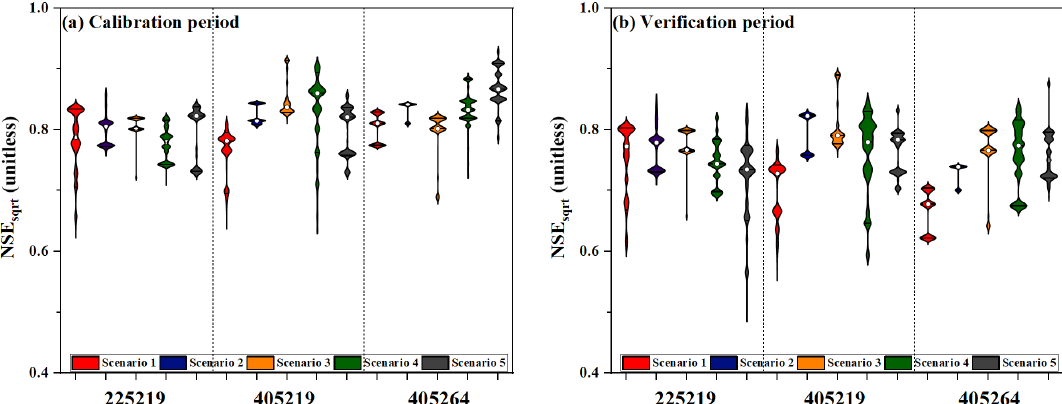
Figure 5. NSE sqrt for each of the five scenarios for each catchment during (a) the calibration period (wet years) and (b) the verification period (dry years). The white dots represent the median estimates of the results.